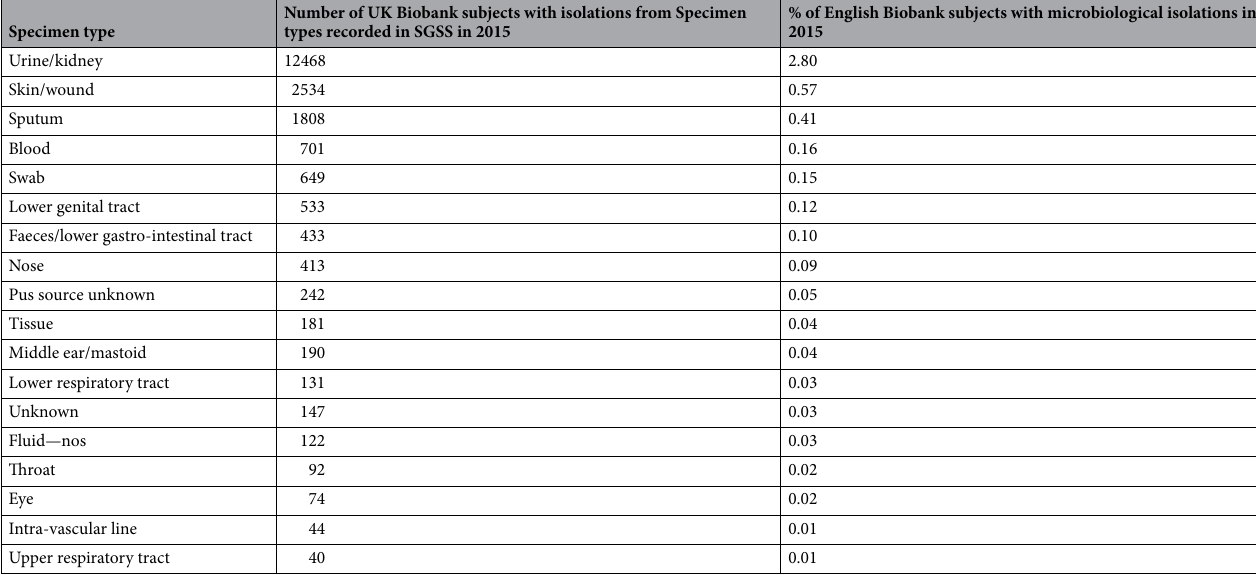
Table 2. The number of UK Biobank participants with samples recorded in SGSS in 2015, stratified by sample type from which the isolate was obtained.